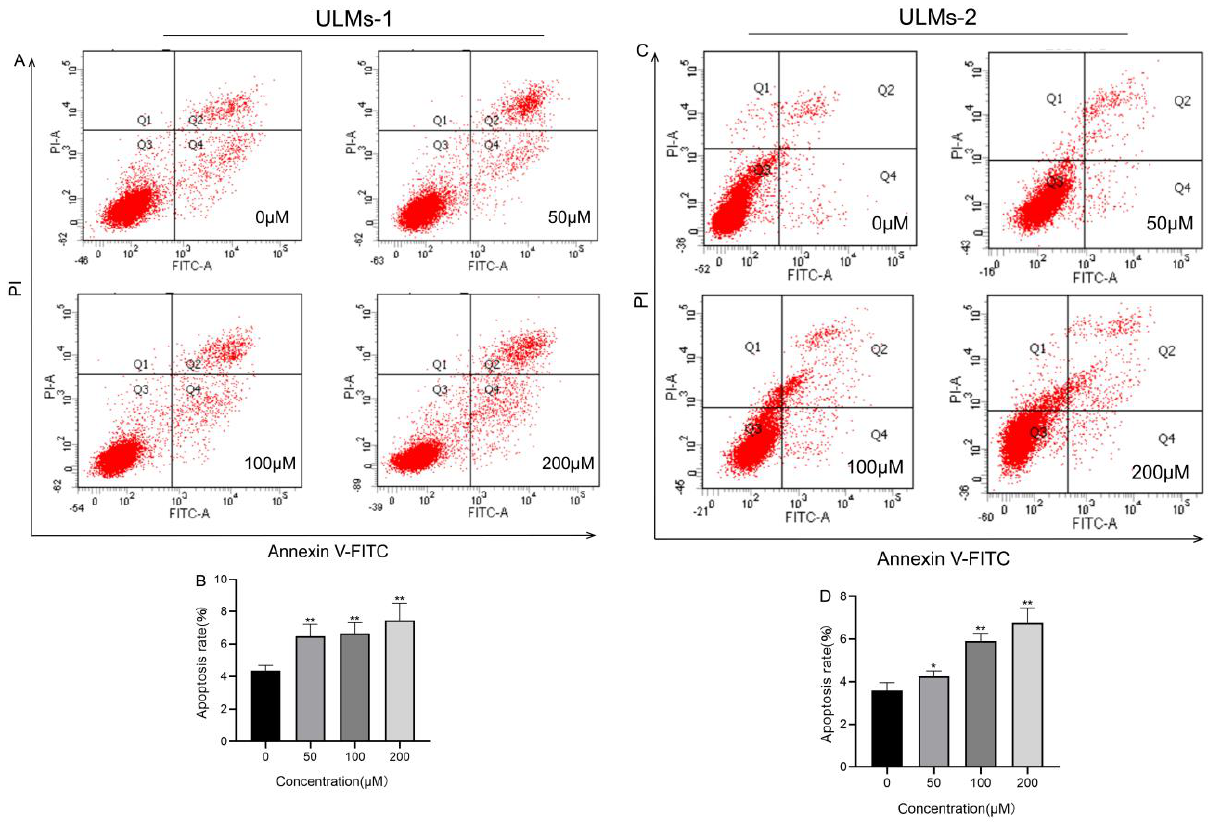
Figure 2. AS−IV induces apoptosis in ULM cells. ULM−1 and ULM−2 cells were treated with various concentrations of AS−IV (0 μM, 50 μM, 100 μM, and 200 μM) for 72 h. Determination of the apoptotic rate of ULM−1 cells ( A , B ) and ULM−2 cells ( C , D ) using an annexin V−FITC/PI apoptosis assay kit. The data are expressed as the mean ± SD. ( * p < 0.05, ** p < 0.01 compared with the control group).